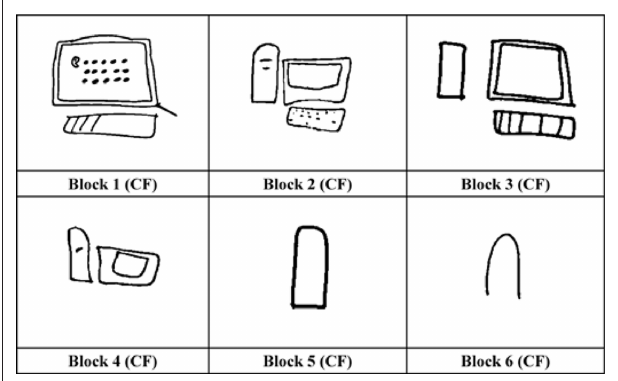
Figure 6 | Drawing refinement and convergence for the concept “Computer monitor” across six games between a pair of interlocutors playing the interactive version of the Pictionary task (adapted from garrod et al.,